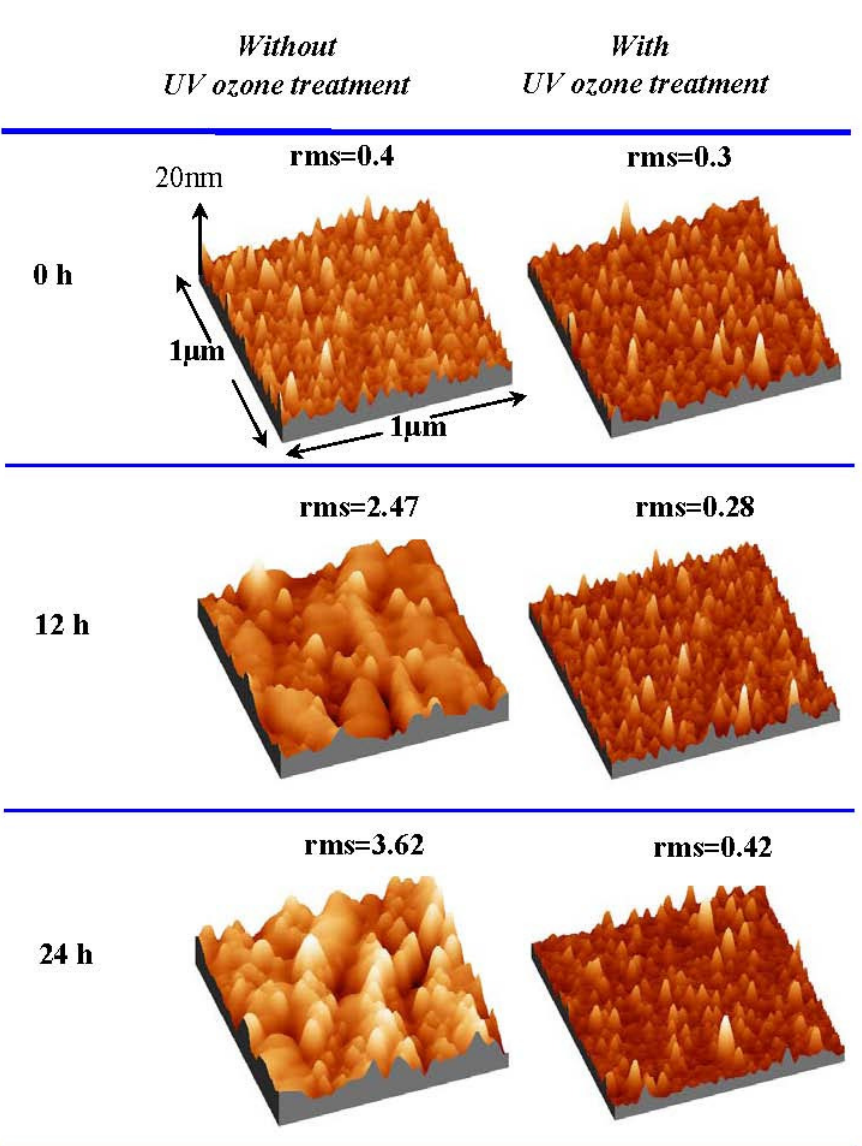
Figure 10. Surface AFM images (1 µ m × 1 µ m) of La ozone treatment after N annealing at 600 °C. Films were exposed to air for different times 2 (Temperature and relative humidity of air: 25 °C and 25%